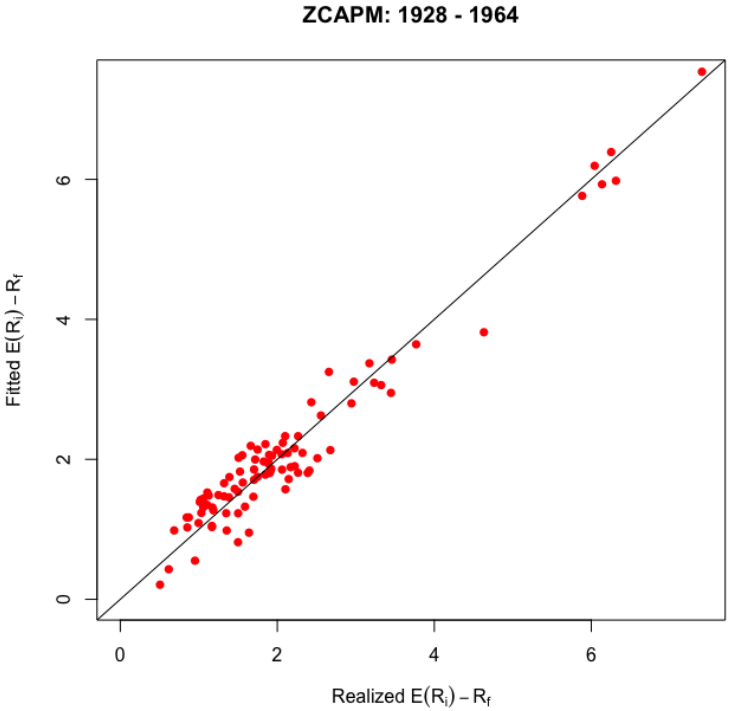
Figure 6. Out-of-sample cross-sectional relationships for the ZCAPM between average one-month- ahead fitted (predicted) excess returns in percent ( y -axis) and average one-month-ahead realized excess returns in percent ( x -axis): January 1928 to December 1964.